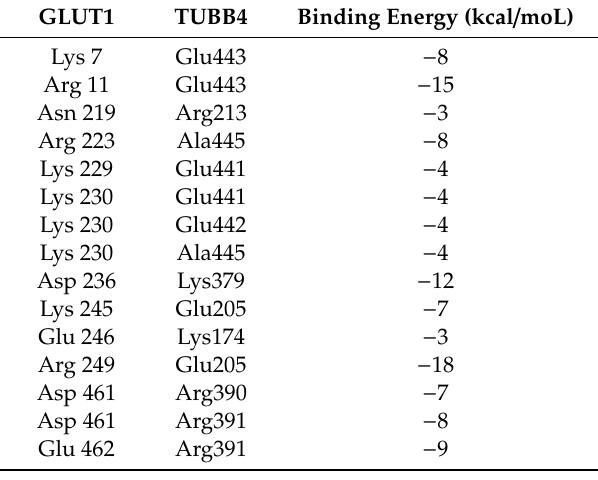
Table 1. Binding energies calculated for GLUT1 and TUBB4. The values are expressed in kcal / moL.